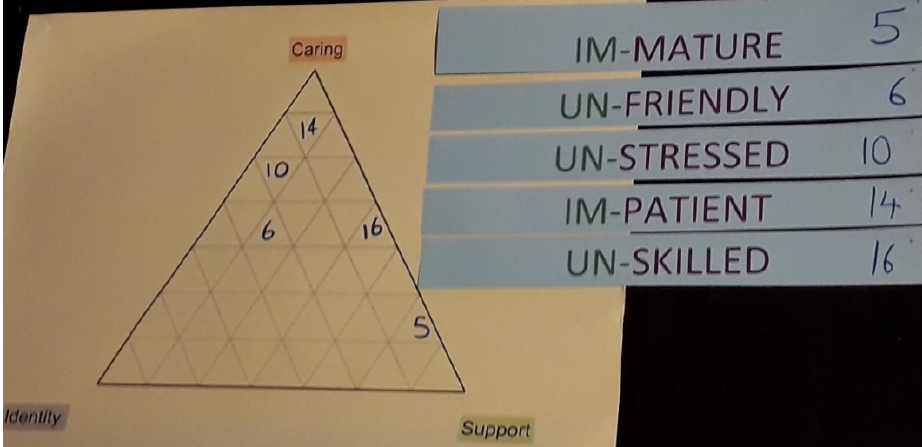
Figure 4. Unsuccessful medical care including attempts to stabilize blood sugar levels resulted in impatience (Impact 14) and a loss of control.